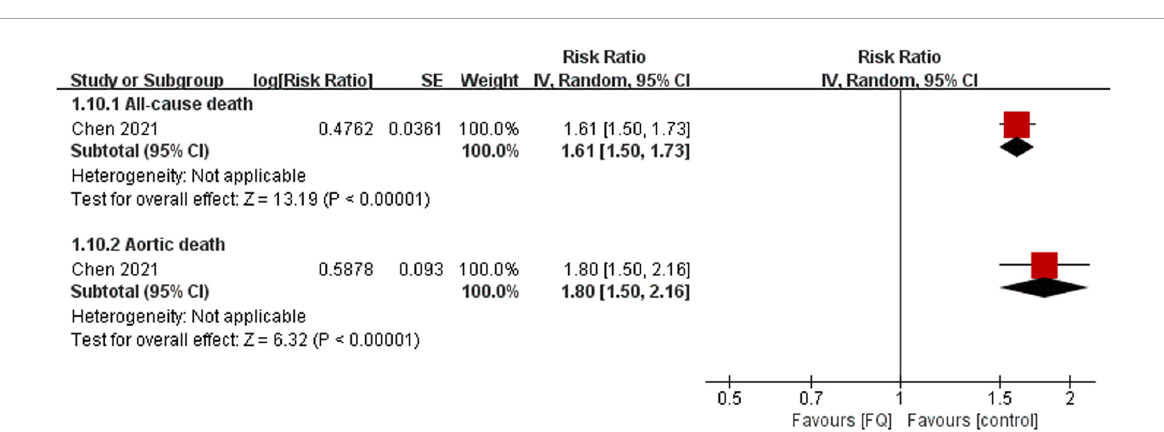
with A1AT deficiency are not typically considered at risk of aortopathy despite maladaptive connective tissue